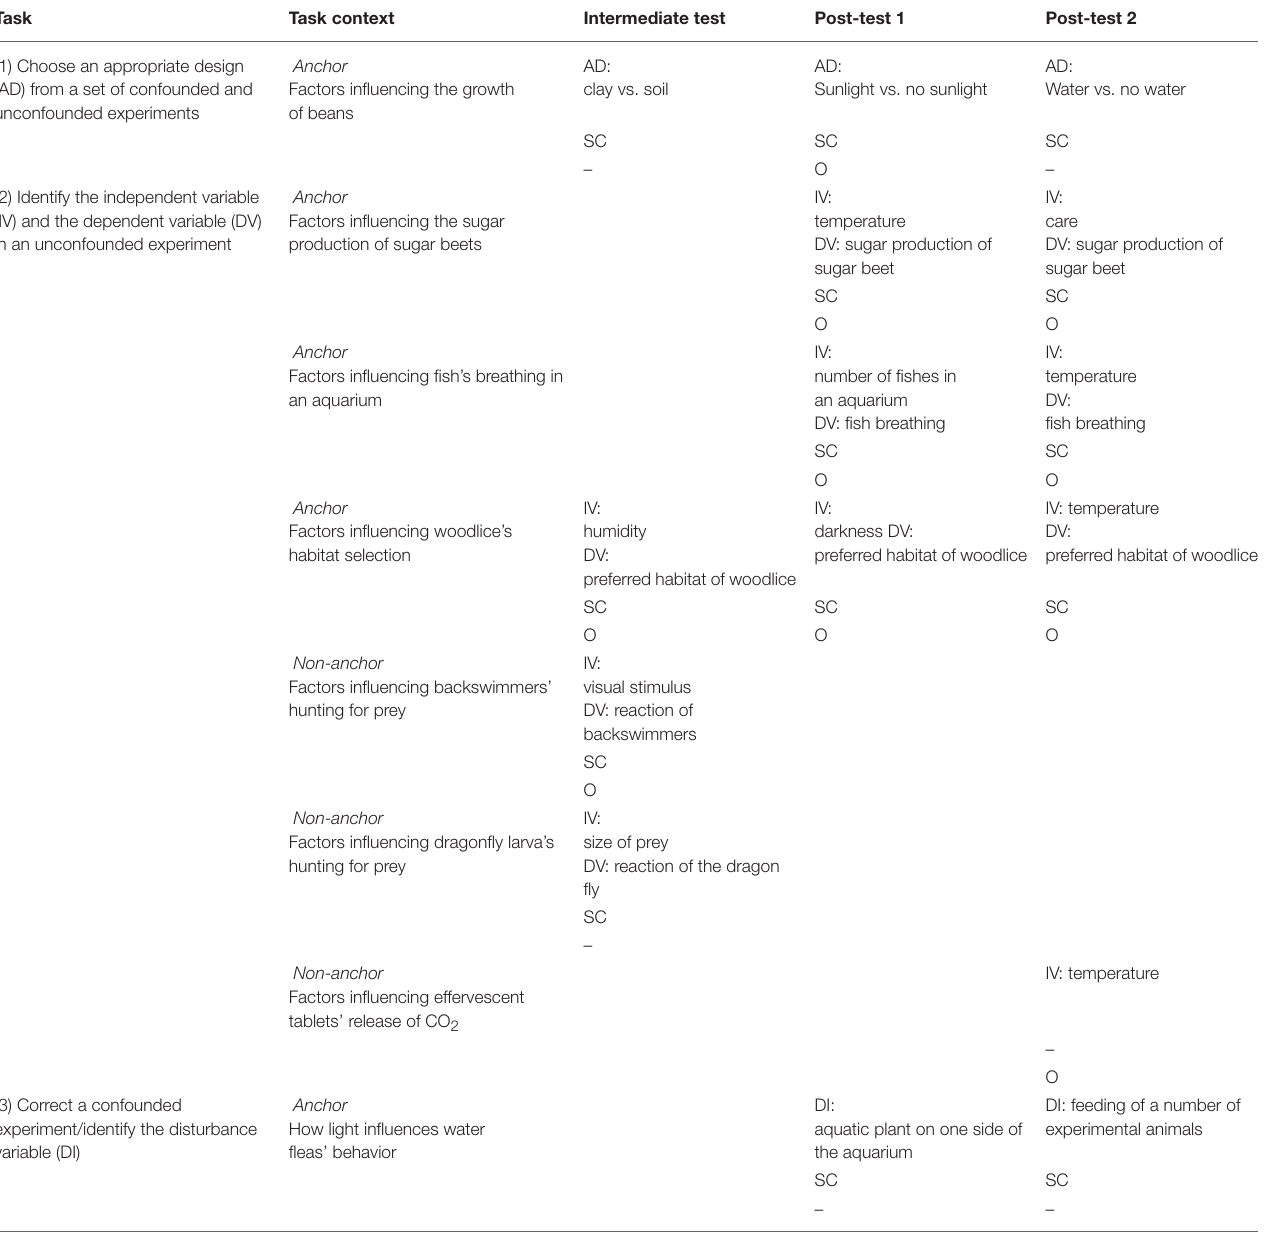
TABLE 2 | Equating facet design with the three dimensions task, task context, task format (SC, O).